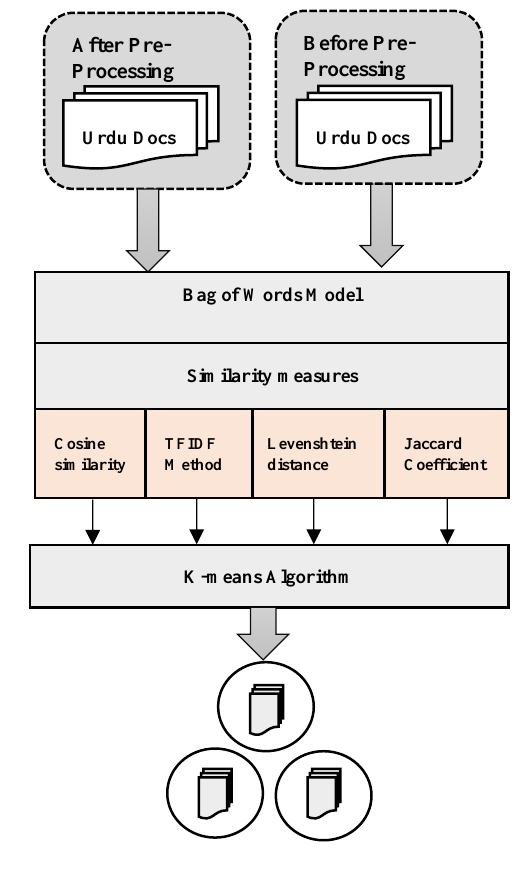
Figure 2 Proposed